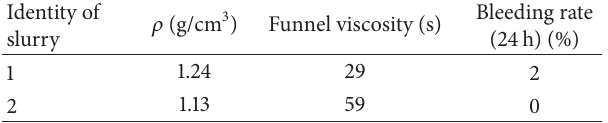
Table 1: Properties of the tested slurries.